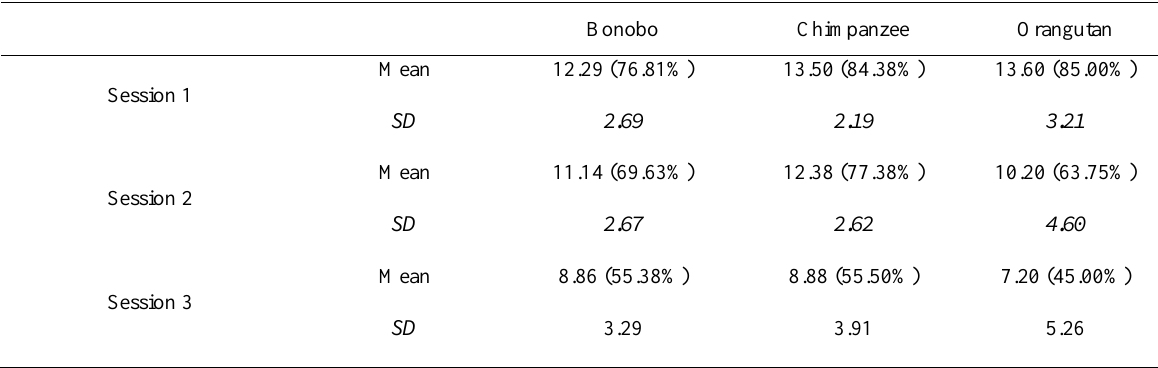
Mean Number of Times the Correct Object Type from the First Experimenter was Given to the Second Experimenter (Percentages in Parentheses) in the First Three Sessions Bonobo Chimpanzee